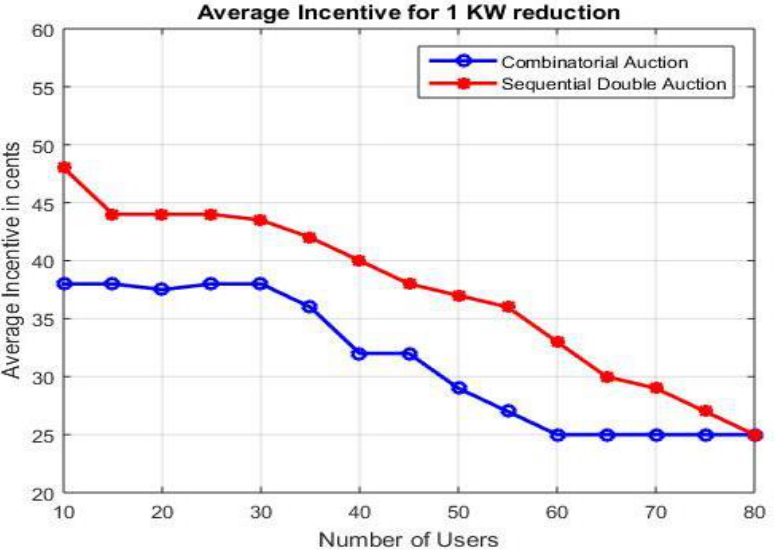
Figure 8. Average incentive per KW reduction.